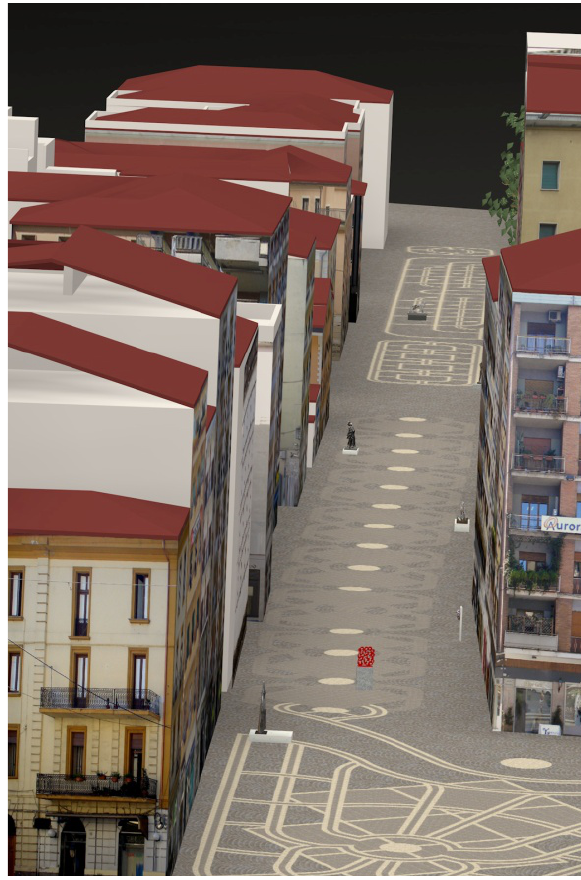
Figure 15. North view of the city model with the present arrangement of the statues.